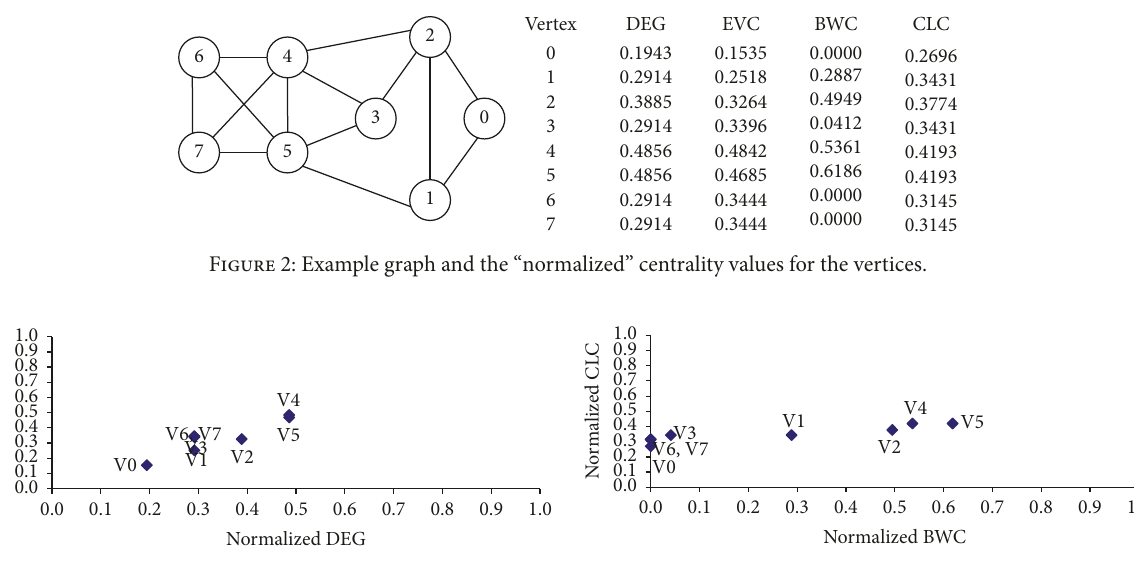
Figure 3: Distribution of the vertices (in the example graph of Figures 1 and 2) in a 2-dimensional coordinate system of the normalized centrality values (DEG-EVC and